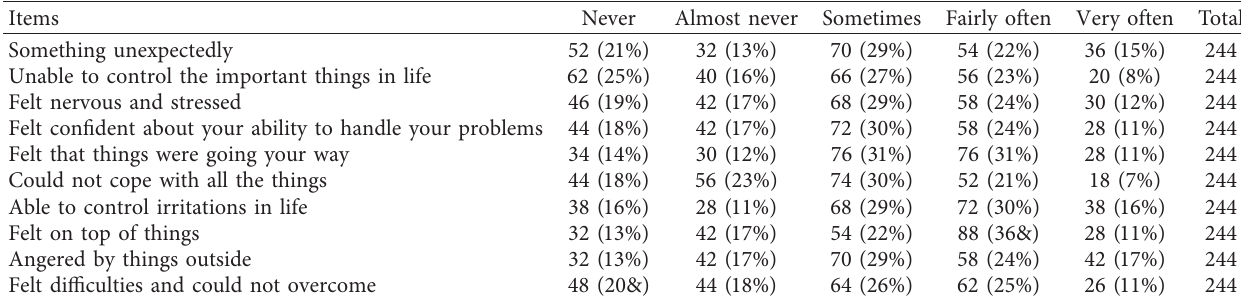
Table 2: Perceived Stress Scale (PSS) among healthcare providers in Dilla town in Dilla, Southern Ethiopia,